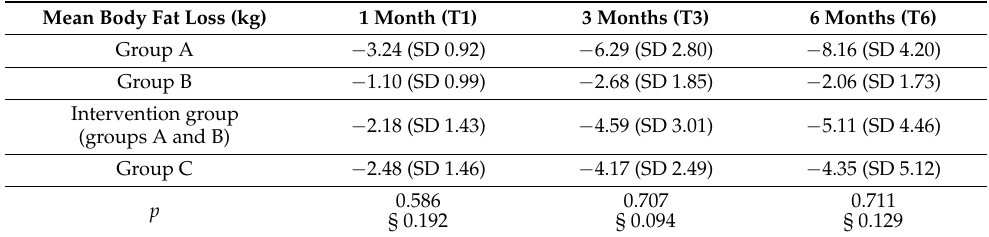
Table 6. Mean body fat loss compared to the baseline, expressed in kg. The results are expressed as mean values of groups A (high dosage—15 mg HT/day), B (low dosage—5 mg HT/day) and C (placebo) at time points T1, T3 and T6. The p -values express the statistical differences between the intervention and placebo groups. The § marker notes the p -values for comparisons between groups A and C. SD: standard